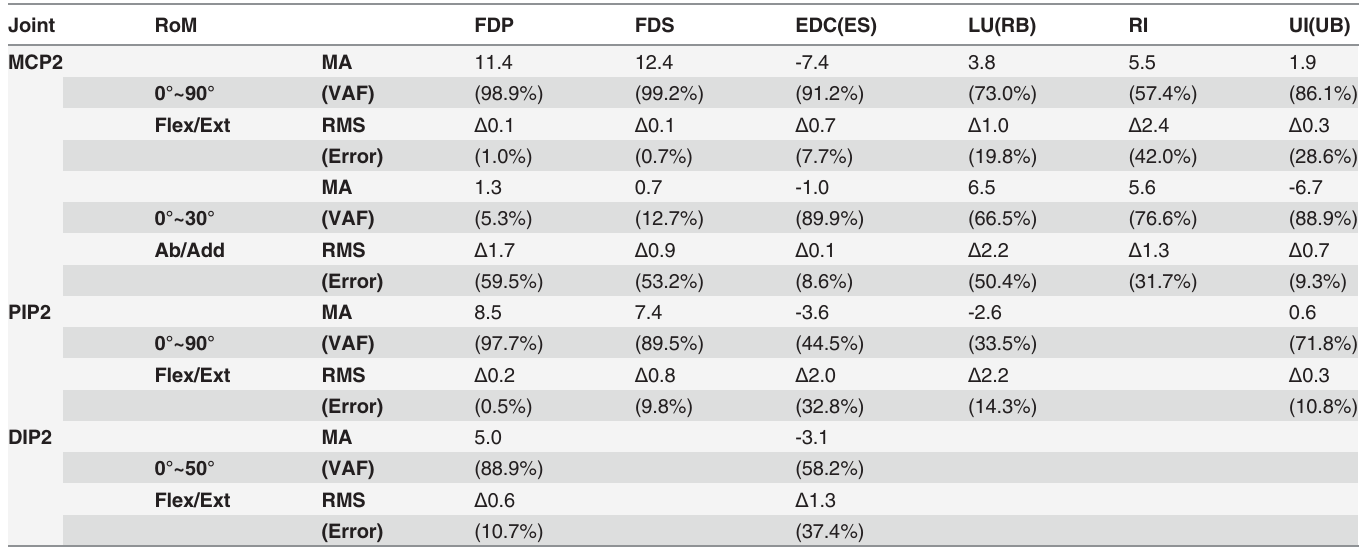
Table 3. Mean moment arms (MA) of the index